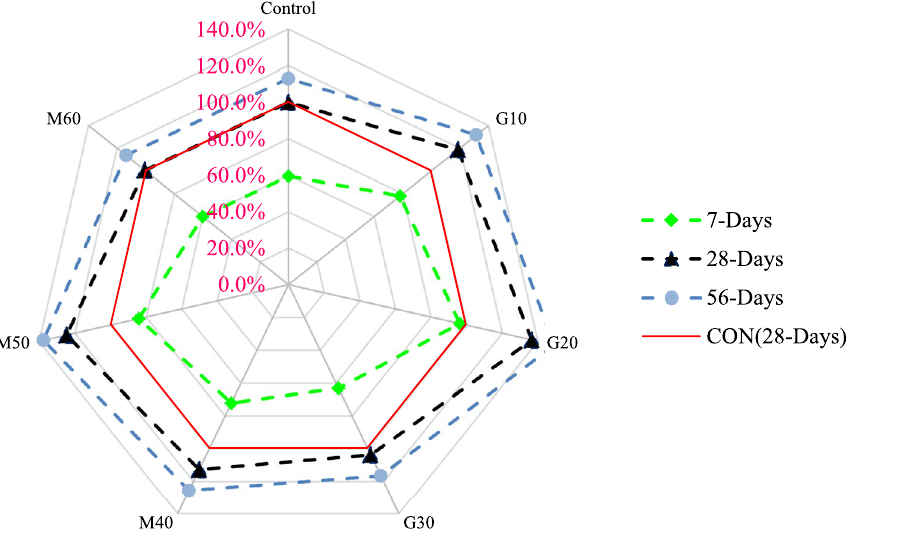
Figure 10. Relative analysis of split tensile